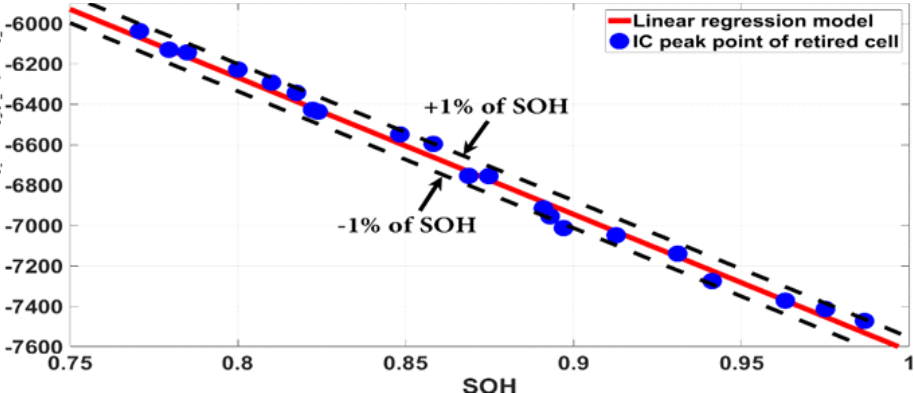
Figure 26. Comparison between the linear regression model based on the IC curve peak point of cell no. 1 cell and a real SOH based on the IC curve peak point of the retired cell.